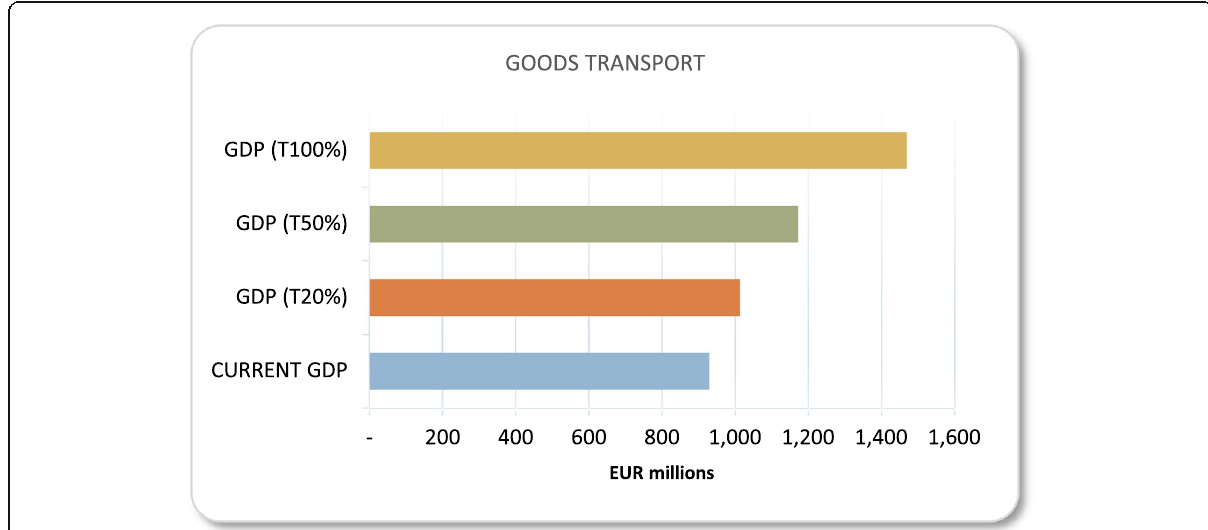
Fig. 10 Spanish GDP forecast for the goods transport industry